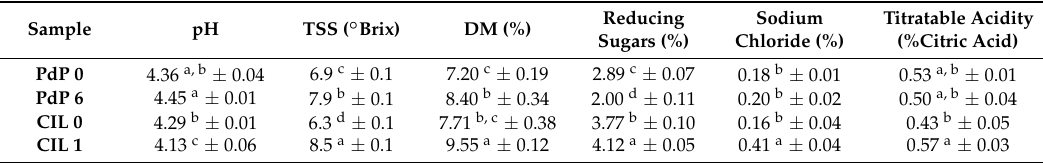
Table 1. pH, total soluble solids (TSS), dry matter (DM), reducing sugar, sodium chloride and titratable acidity (mean ± standard deviation) detected in tomato